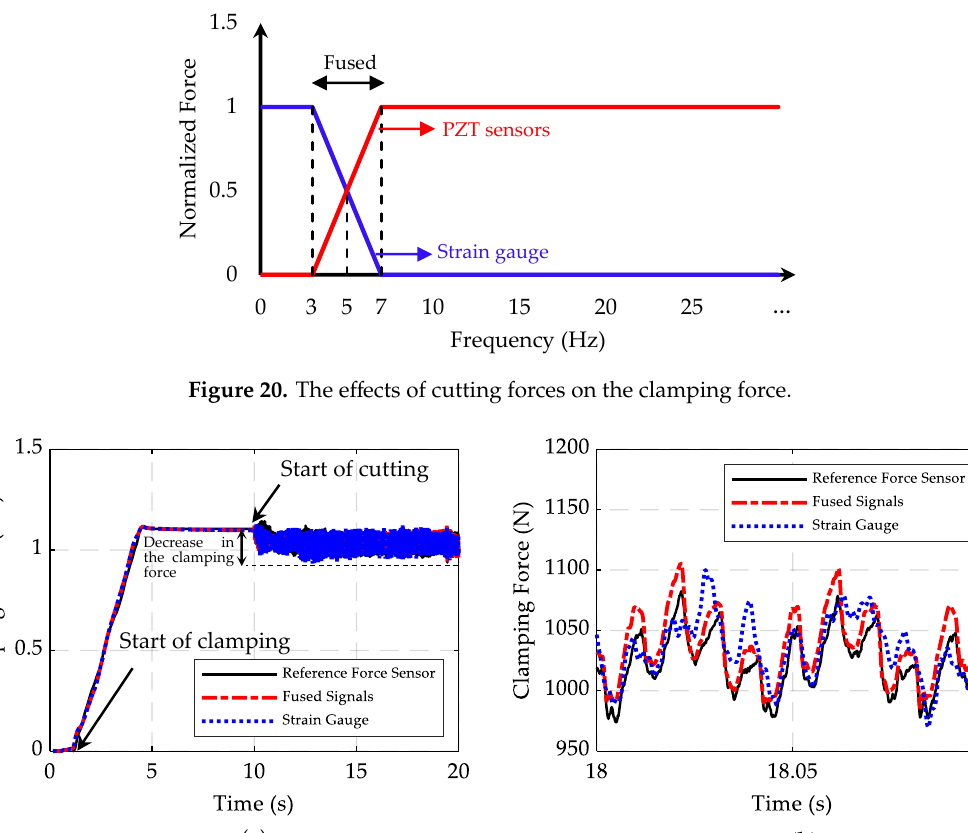
Figure 21. Comparing the measured forces: ( a ) from the start of clamping followed by cutting; ( b ) at the cutting section.